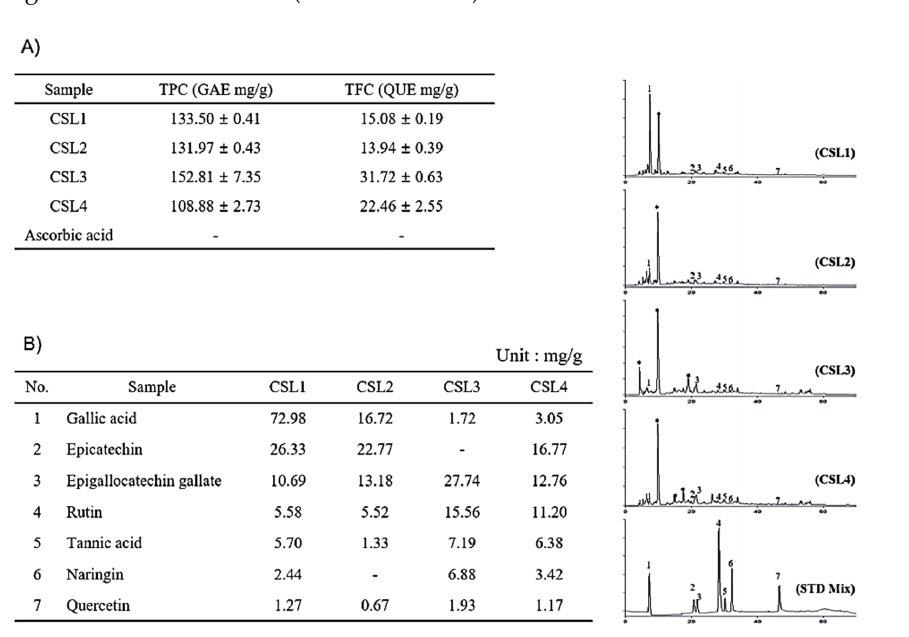
Figure 3. Identification of components in CSL3 and CSL extracts. ( A ) The TPC and TFC were determined using colorimetric methods. ( B ) HPLC chromatogram of CSL extracts. Gallic acid (peak 1), epicatechin (peak 2), EGCG (peak 3), rutin (peak 4), tannic acid (peak 5), naringin (peak 6), and quercetin (peak 7).